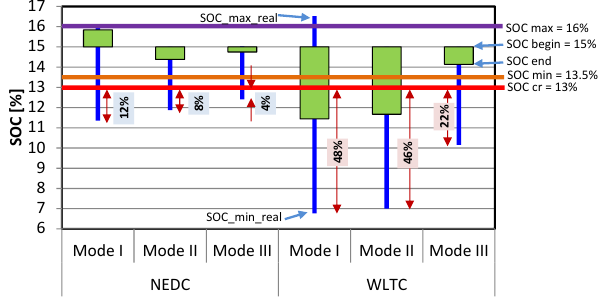
Fig. 12. Comparison of control algorithms in the Range Extender system in the two research